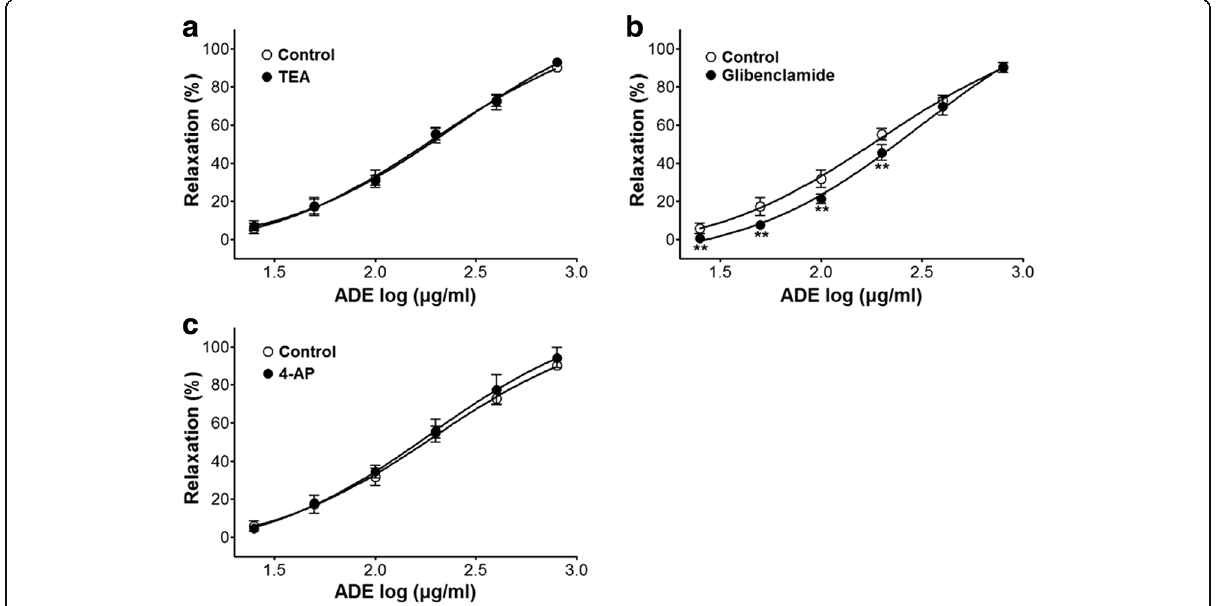
Fig. 3 Concentration-response curves to ADE on endothelium-intact aortic rings precontracted by PE (1 μ M) in the presence or absence (not pre-treated control) of TEA (5 mM) ( a ), glibenclamide (10 μ M) ( b ), or 4-AP (1 mM) ( c ). Values are expressed as mean ± SEM (n = 5 – 8, number of aortic rings). ** P < 0.01 vs. control